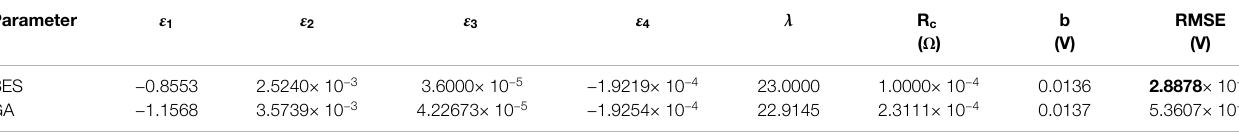
TABLE 4 | PEMFC parameter identi fi cation results.